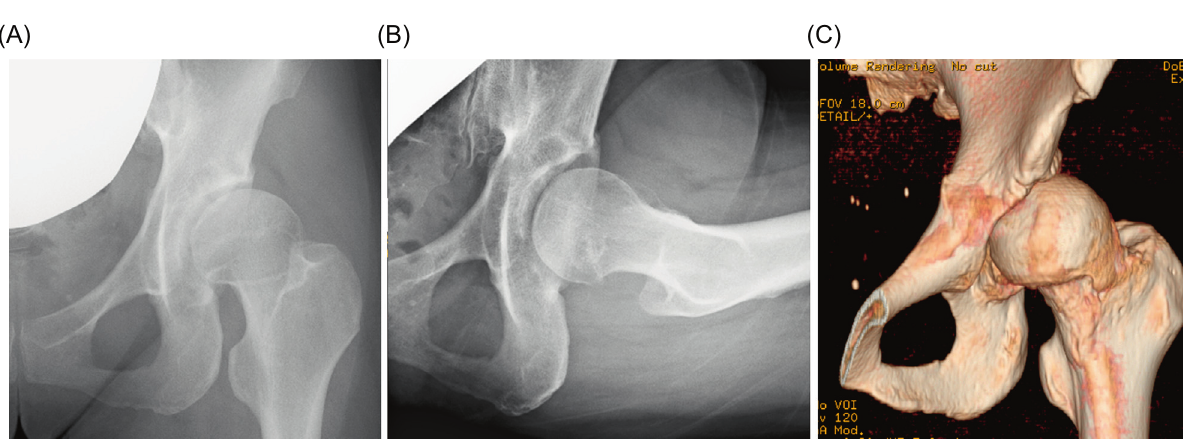
Figure 1. Pre-operative radiograph showing slight osteoarthritis due to hip dysplasia (A); bump on the femoral head-neck junction, with an alpha angle of 75 (cid:3) (B); pre-operative three-dimensional reconstruction of the computed tomography (CT) image